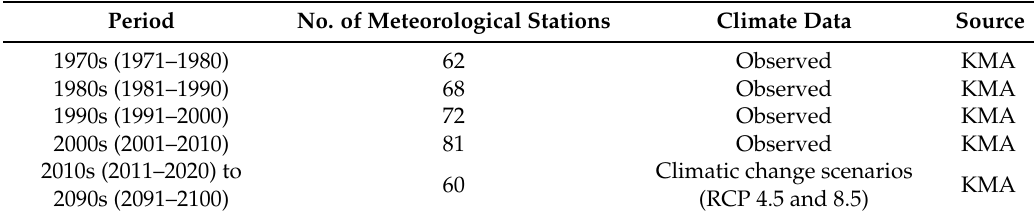
Table 1. Past climate data and future climate change scenarios used in this study.